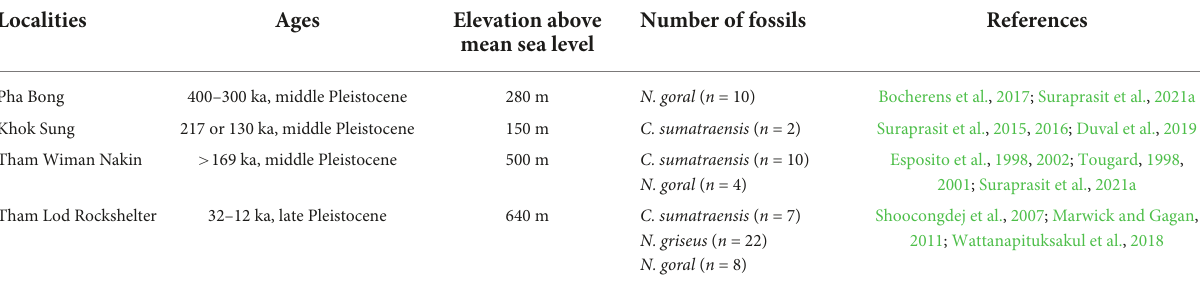
TABLE 1 General information of four paleontological and archeological sites and the number of specimens in this